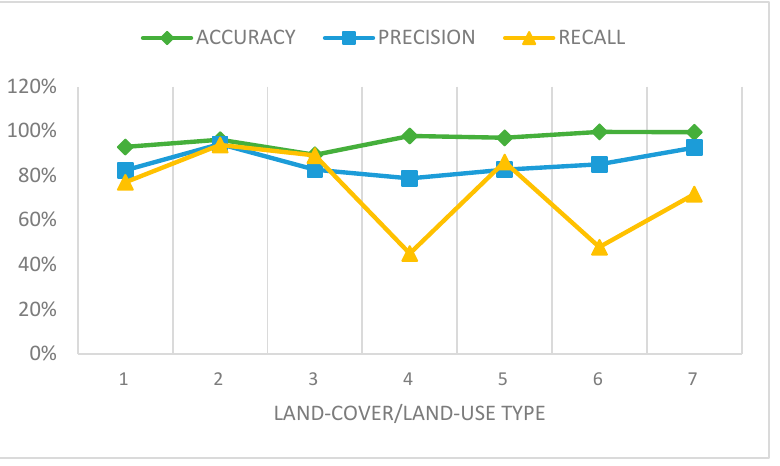
Figure 9. The plot of accuracy, precision, and recall values based on the average of seven land- use/land cover